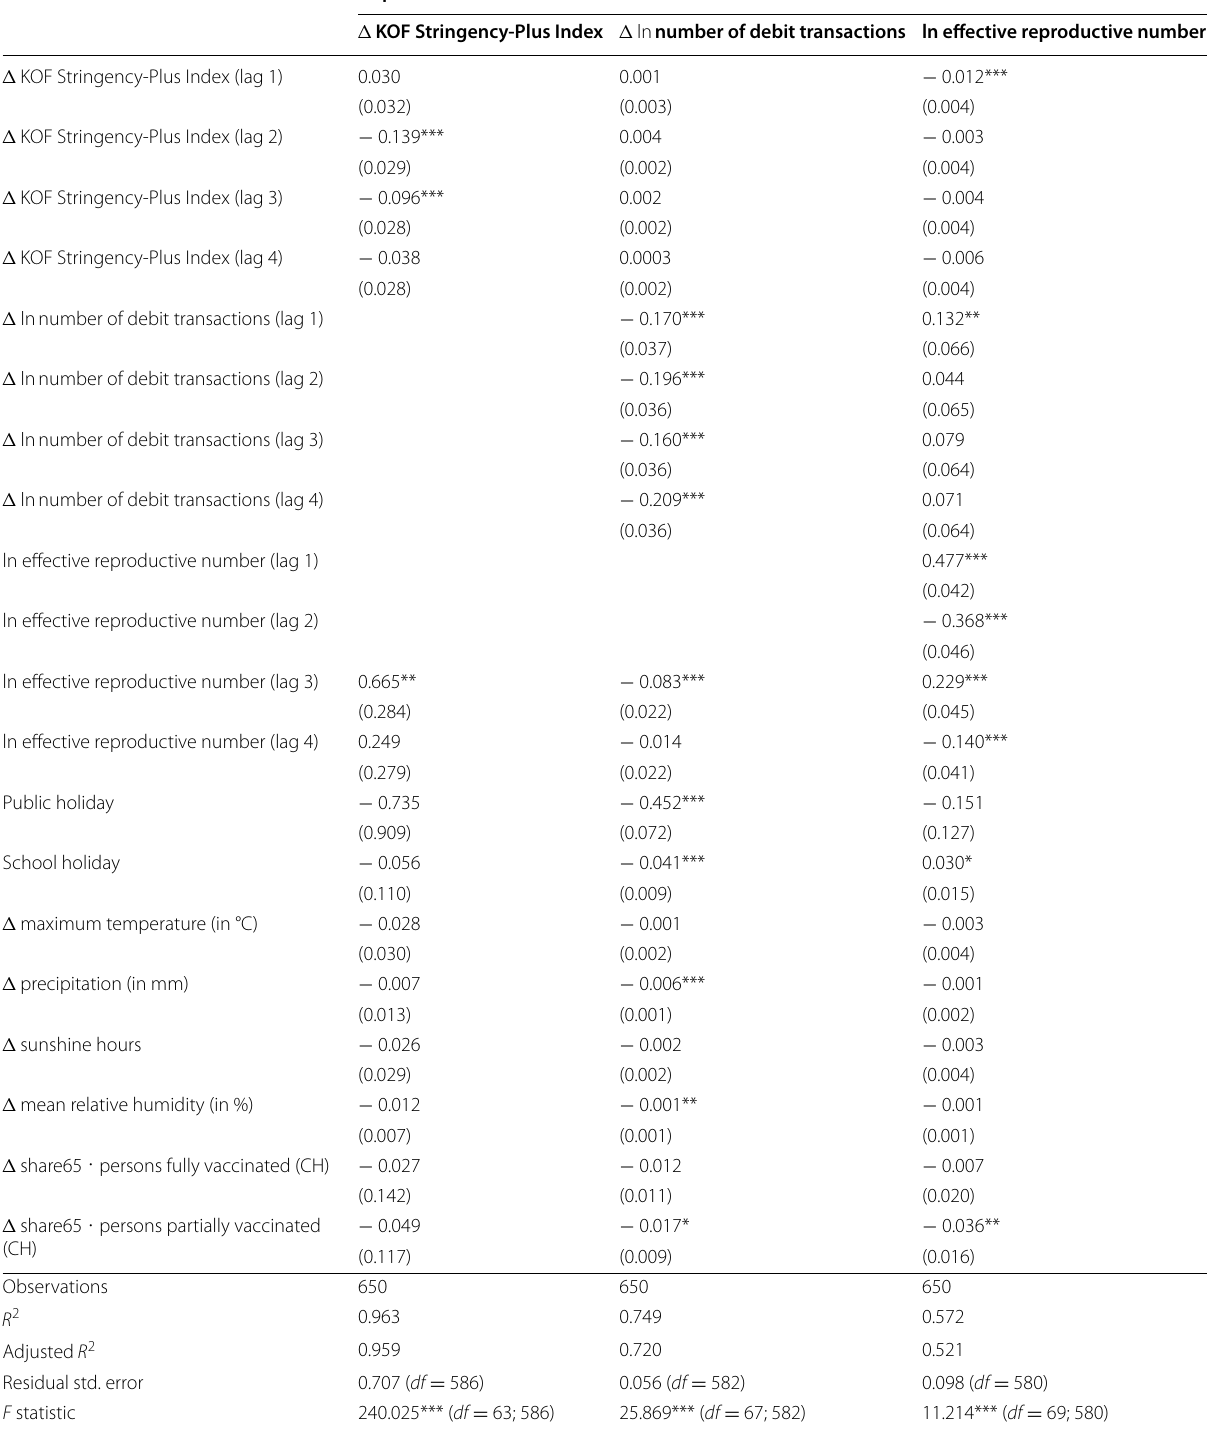
Table 3 VAR(3) with canton and time fixed